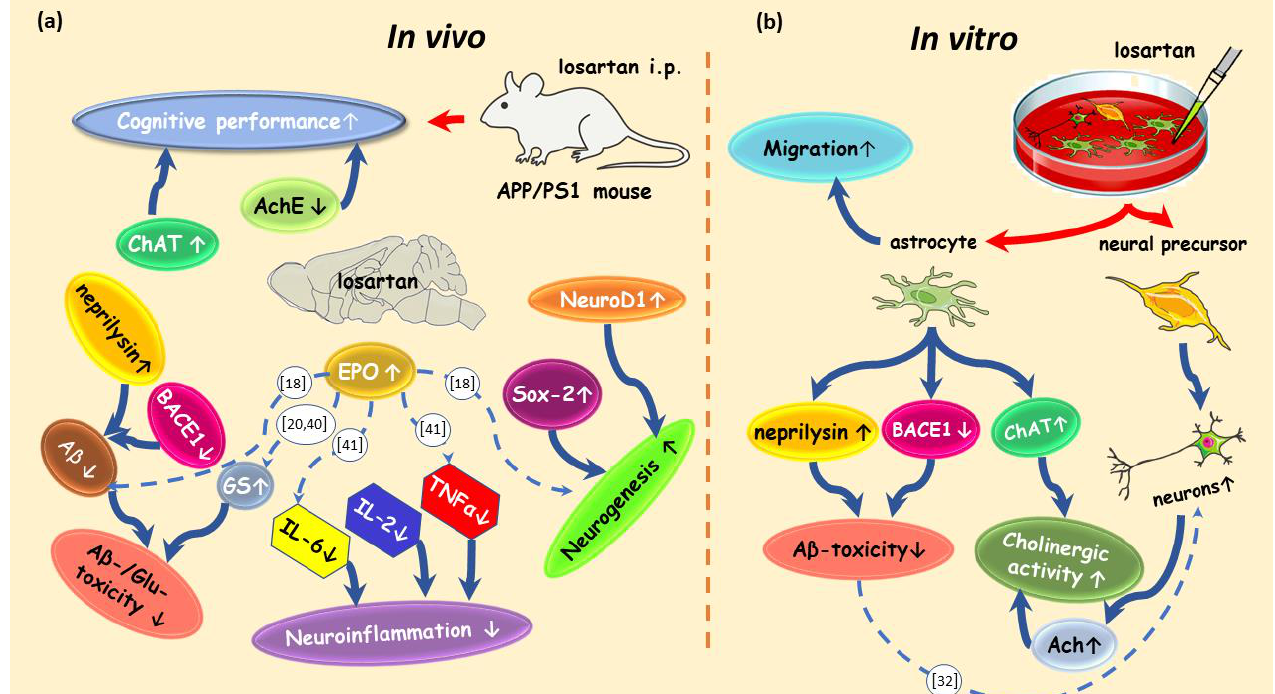
Figure 8. Schematic illustration of processes influenced by losartan in an AD-like pathology in vivo and in vitro. ( a ) In vivo effects of losartan in a transgenic model of AD (APP/PS1 mouse). Intraperitoneal administration of losartan led to a decrease in: Acetylcholine esterase (AchE), TNF α , IL-6, IL-2, β secretase 1 (BACE1), and beta amyloid (A β ), and to an increase in Choline acetyltransferase (ChAT), glutamine synthetase (GS), neprilysin, SRY-related HMG-box 2 (Sox-2), Neuronal Differentiation 1 protein (NeuroD1) and erythropoietin (EPO). Blue solid arrows connect the processes (neurogenesis, neuroinflammation, cholinergic activity and A β /Glutamate (Glu)-toxicity) with their respective markers. Dashed blue arrows show the effect of EPO on GS, TNF α , IL-6 and neurogenesis evidenced by the literature indicated in white circles; ( b ) in vitro effects of losartan on the astrocytes and neural precursors. Losartan induced the differentiation of neurons from neural precursors, increased the Acetylcholine (ACh) in neurons, decreased the expression of BACE1 and upregulated ChAT and neprilysin in astrocytes. Losartan improved the motility and migration of astrocytes. This schematic drawing was created using art elements from Servier Medical Art Commons Attribution 3.0 Unported License. Servier Medical